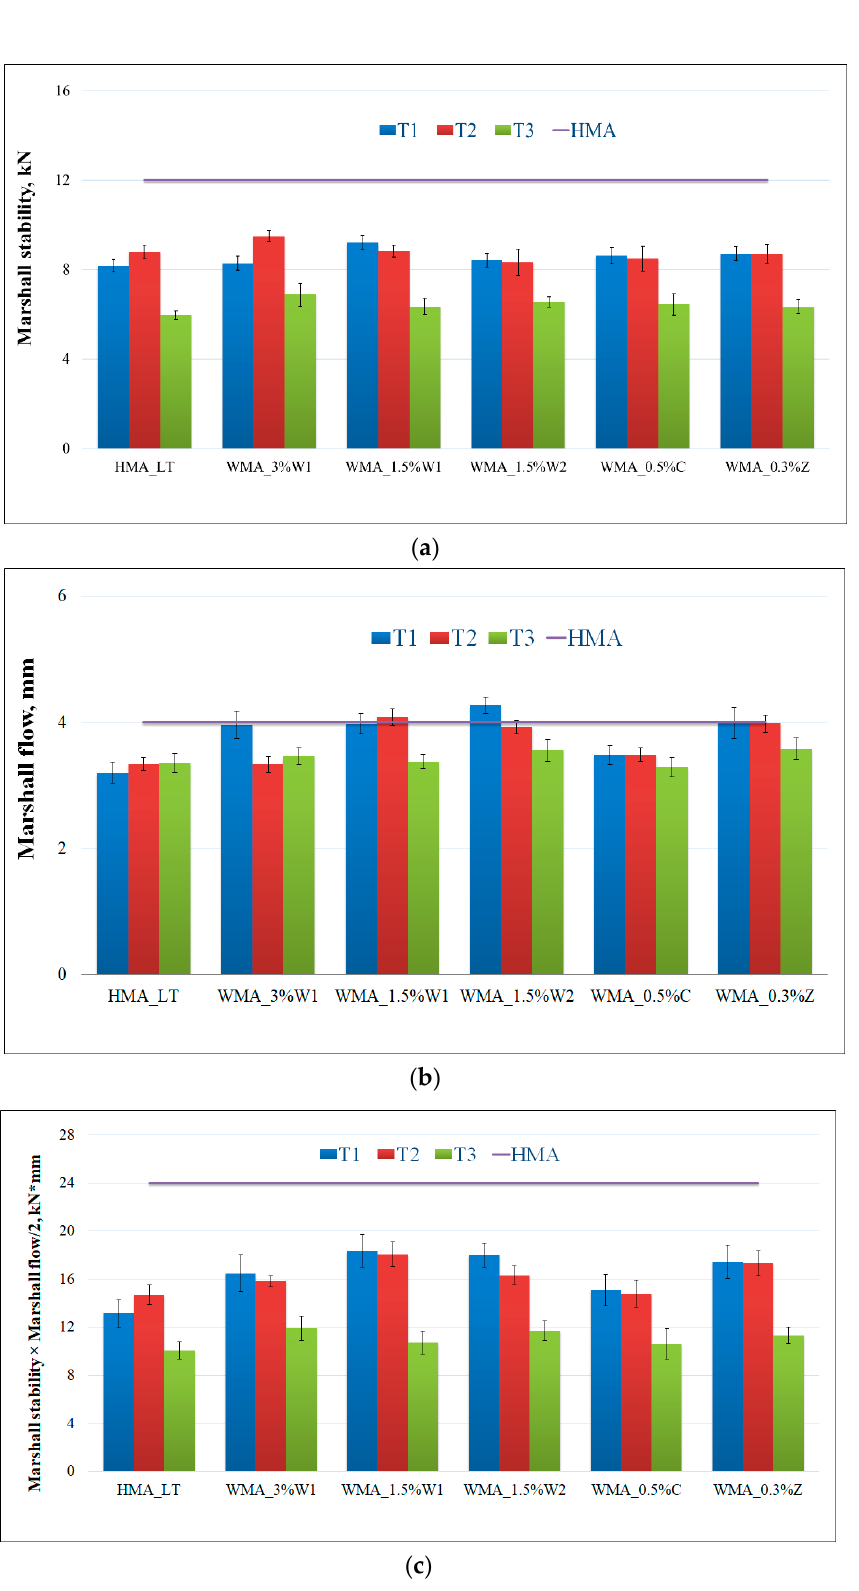
Figure 6. Marshall test results: ( a ) Marshall stability; ( b ) Marshall flow; ( c ) (Marshall stability × Marshall flow)/2 (length of the error bar is equal to one standard deviation).